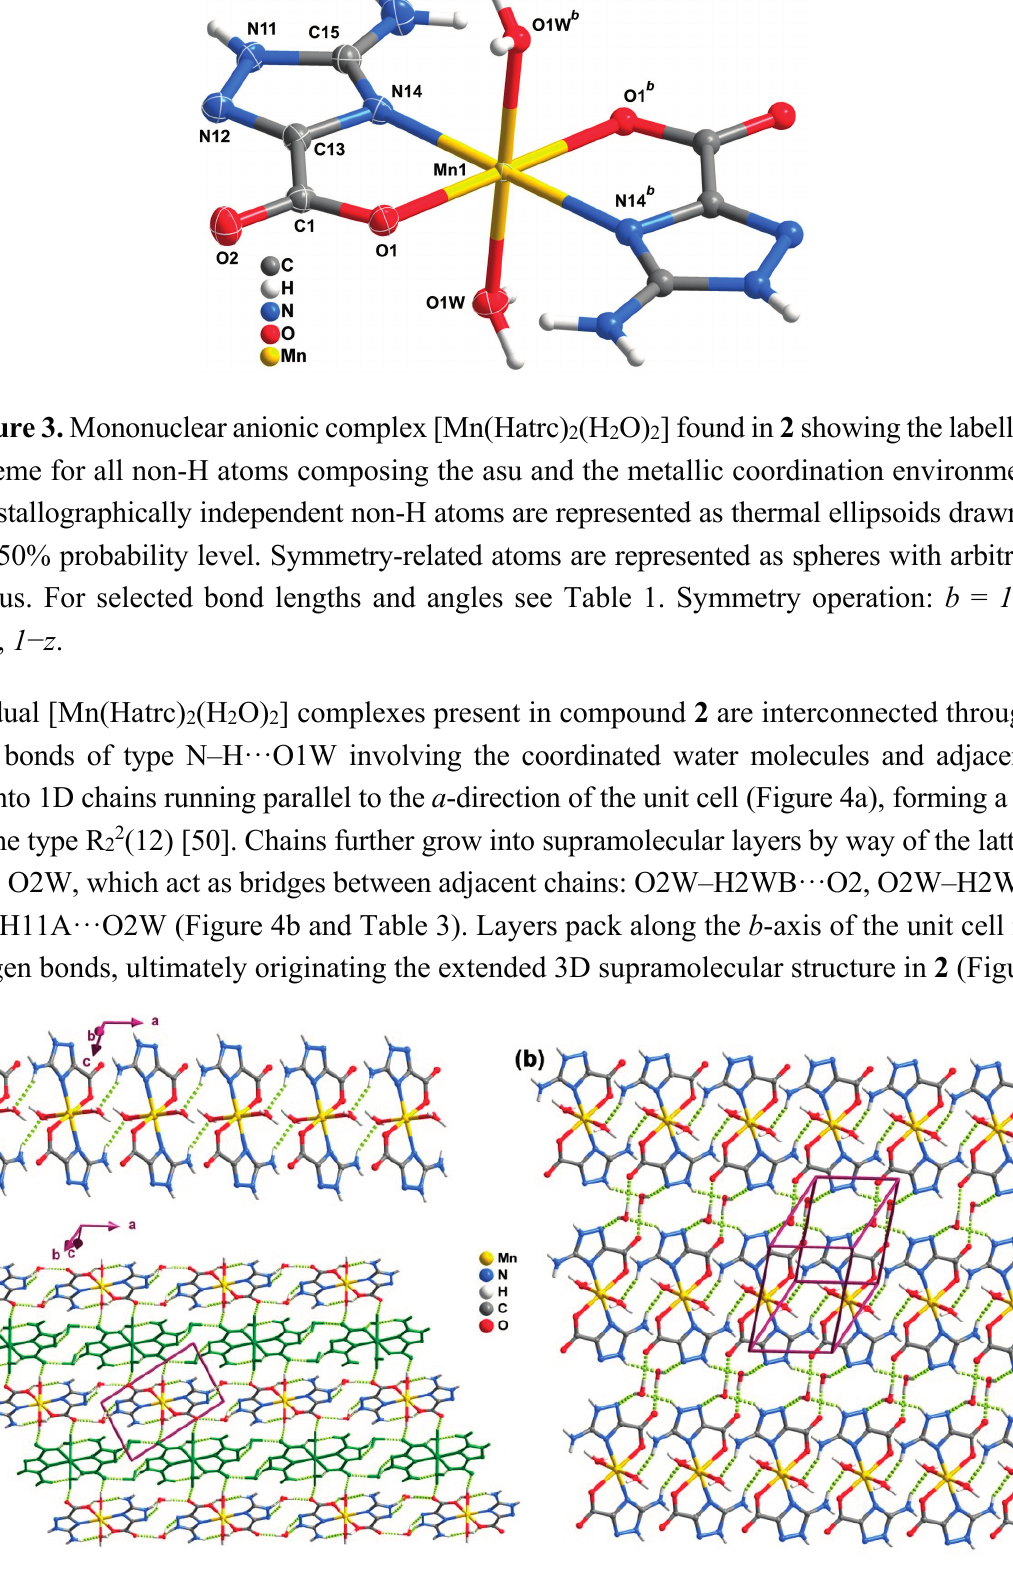
Figure 4. Ball-and-stick representation of ( a ) the 1D hydrogen-bonded chain; ( b ) the 2D layer and ( c ) the 3D supramolecular network (layers alternating between original and green color) present in compound 2 . Hydrogen bonds are represented by dashed light-green lines. For details on the represented interactions see Table